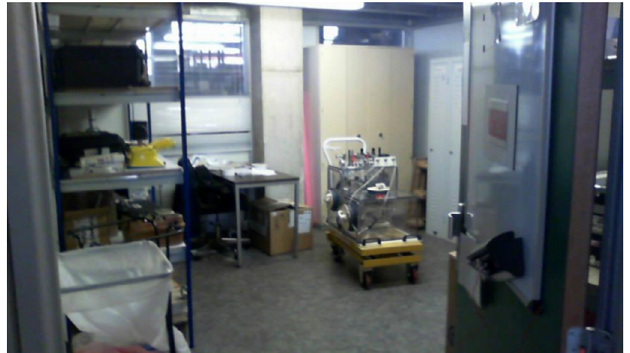
Fig. 15. Benchmark situation. Room dimensions: 25 m 2 , 2.5m high. Table 1. Comparison data.